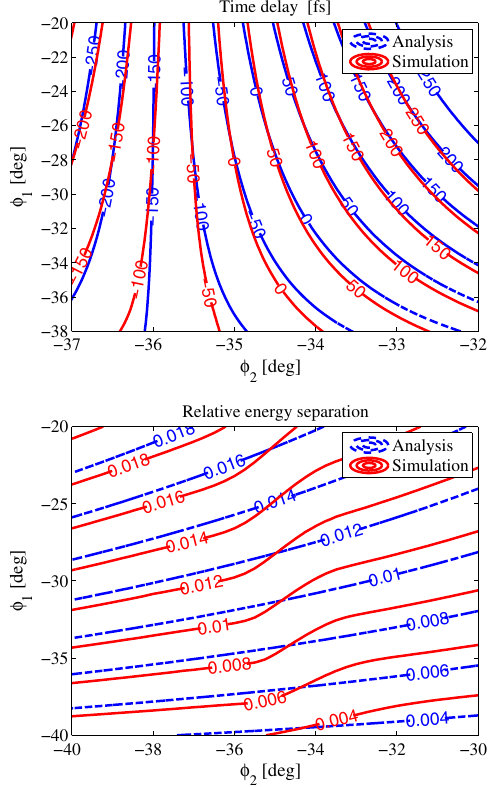
FIG. 5. The contours of the time delay (up) and relative energy separation (down) of the two bunches. The blue dashed line is the analysis results of Eqs. (3) and (4) and the red line is the simulation results of L I T RACK with the linac wakefields. The amplitude of L1X in this simulation is set to be zero.